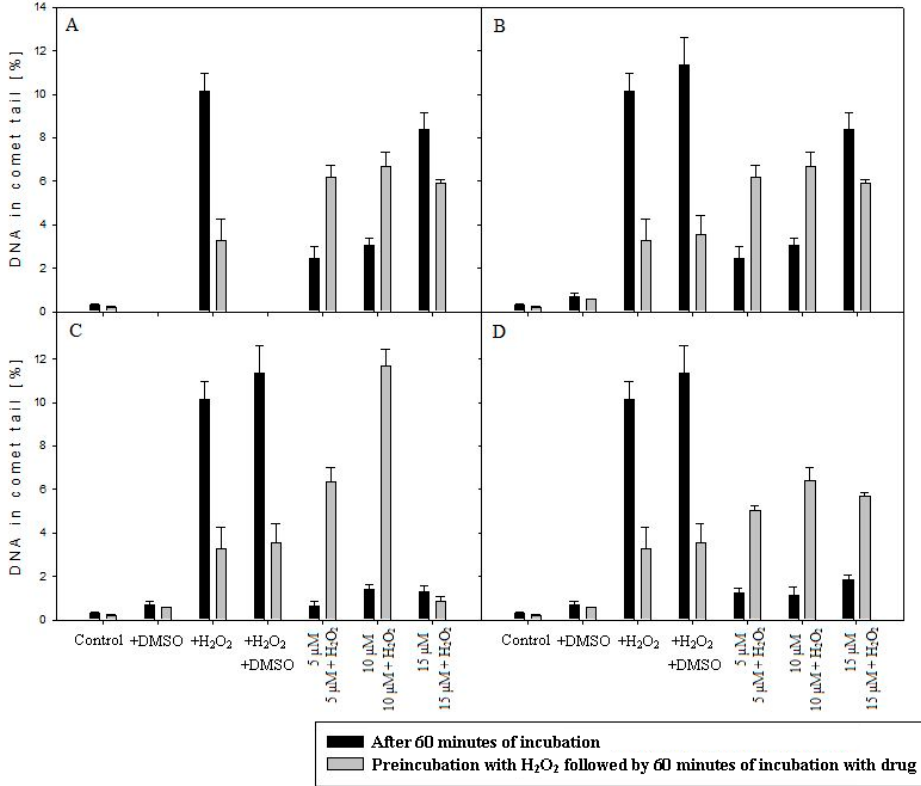
Figure 6. DNA damage in leukemia cells induced by 1a ( A ), 1b ( B ), 2a ( C ) and 2b ( D ) (60 min, 37 °C) at concentrations of 5, 10 and 15 µM with and without prior H 2 O 2 incubation (10 min, 4 °C) at a concentration of 15 µM with respect to the appropriate control ( − H 2 O 2 /+H 2 O 2 ). The values were measured as the average percentage of DNA in the comet tail ± SEM using alkaline version of comet assay.